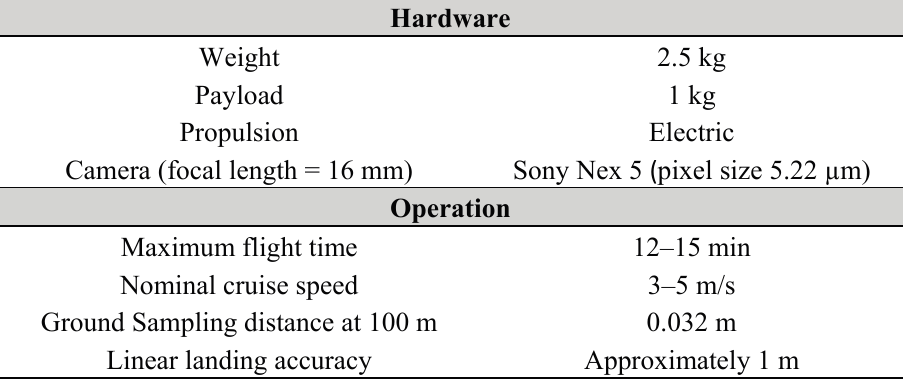
Table 1. Main technical features of the employed multi-rotor